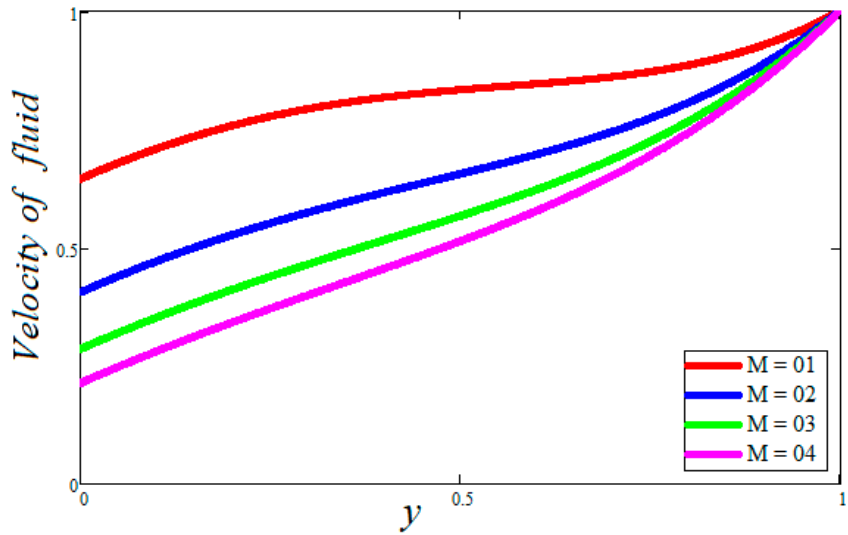
Figure 8. Impact of M on the profile of fluid velocity.